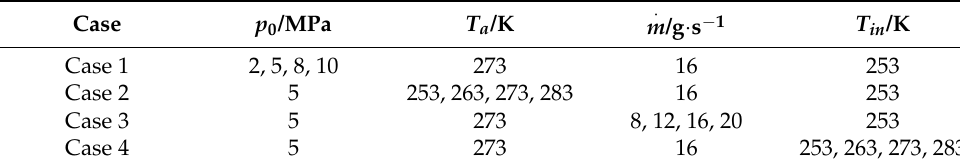
Table 4. Filling parameters under different filling